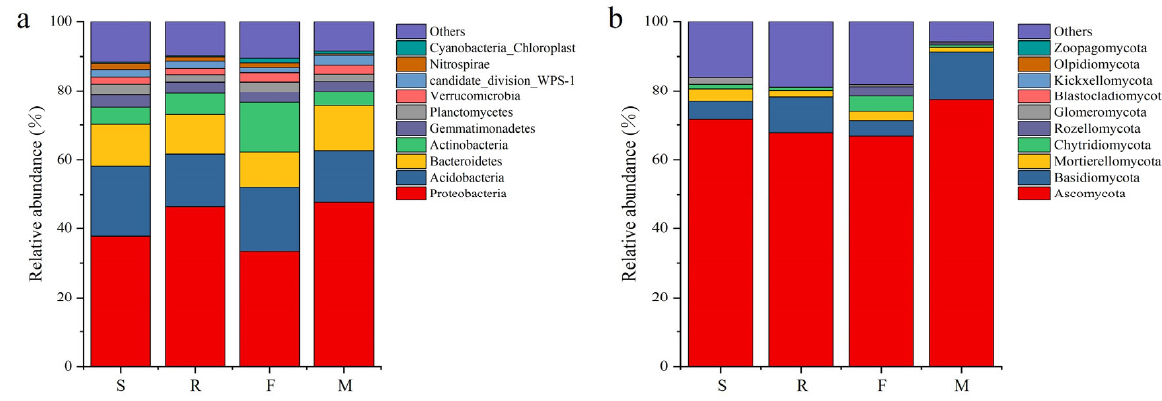
Figure 1. The relative abundance of bacterial ( a ) and fungal ( b ) community composition at the phyla level. S, R, F, and M represent the seedling stage, rapid growth stage, flowering stage, and maturity stage, respectively.